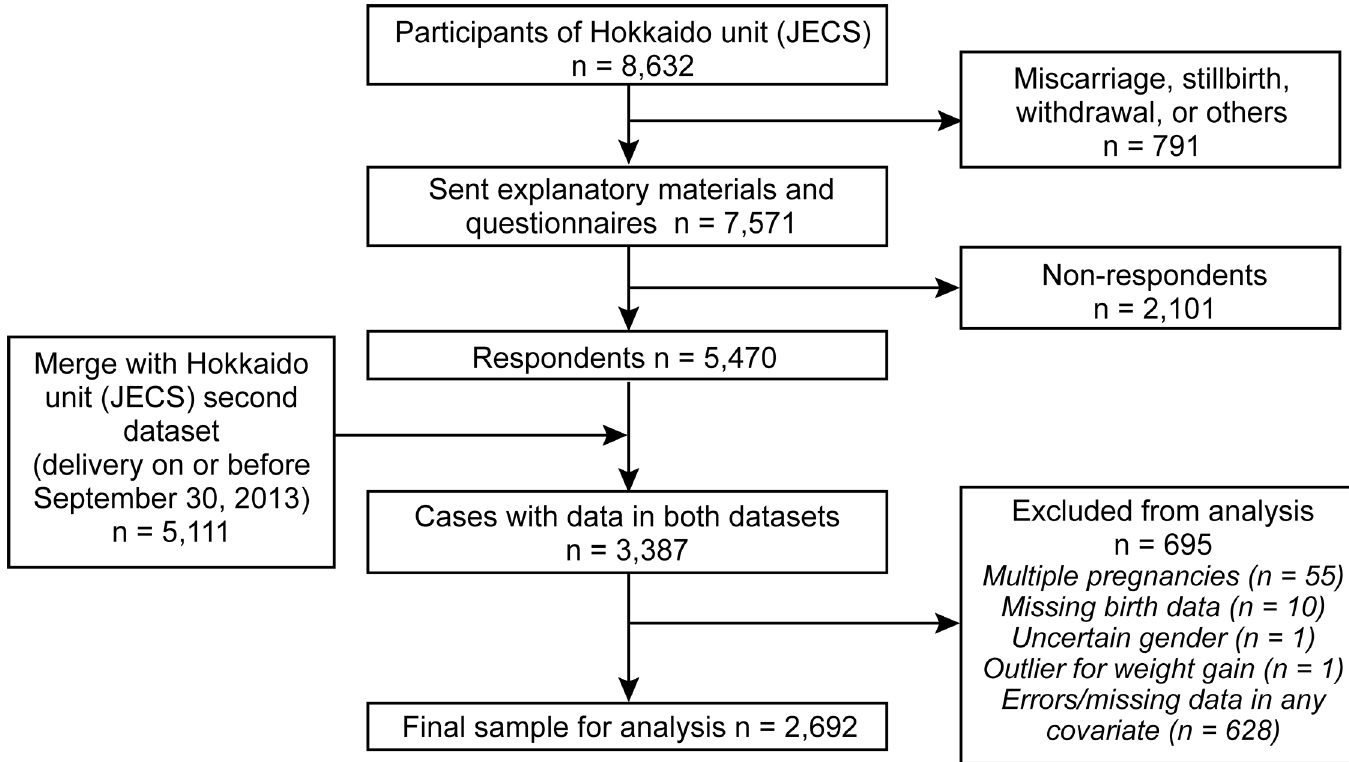
Fig 1. The sample selection flow diagram.